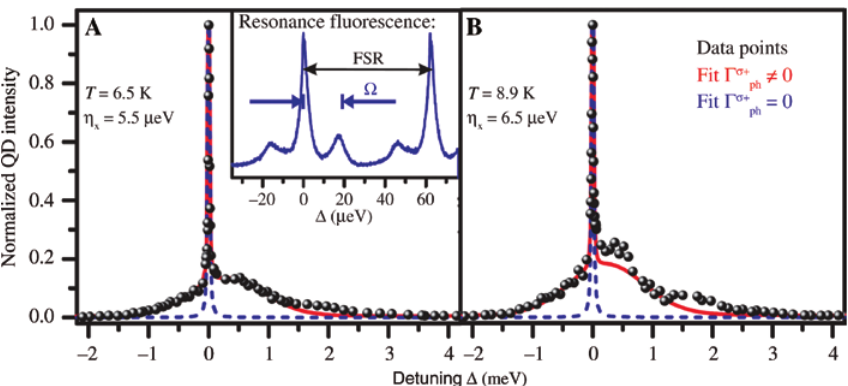
Figure 8: Integrated QD intensity derived from a frequency scan (black dots, experiment) and theory with (red) and without (blue) phonon- included processes on the basis of the polaron master equation for different temperatures (A) and (B). Reprinted figure with permission from [50]. © 2012 by the American Physical